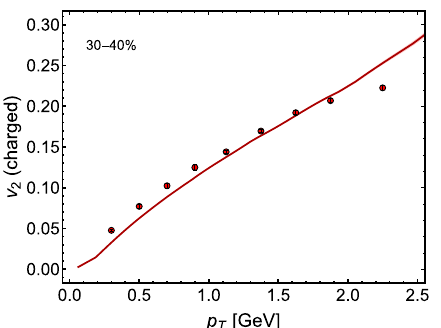
Fig. 8 The elliptic flow v 2 for charged particles in 30–40% centrality class is shown where the solid line is the prediction of 3+1D aHydroQP and the points are the experimental results from the ALICE Collabora- tion [71]